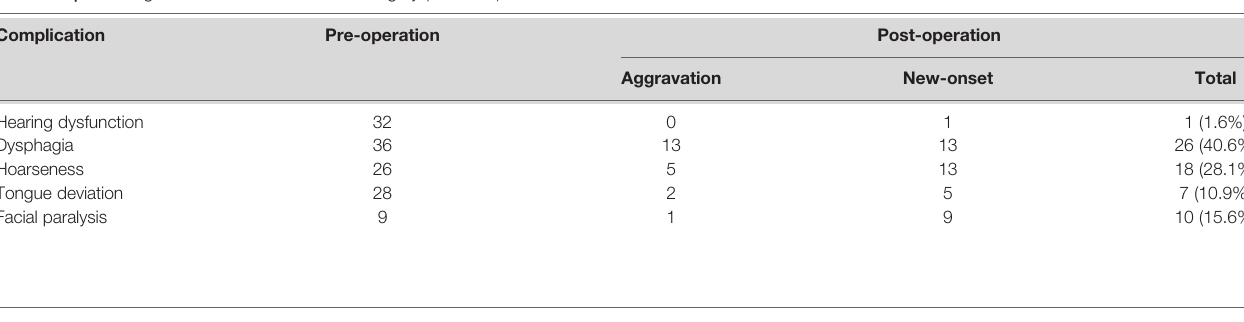
TABLE 2 | Neurological de fi cits before and after surgery (64 cases).